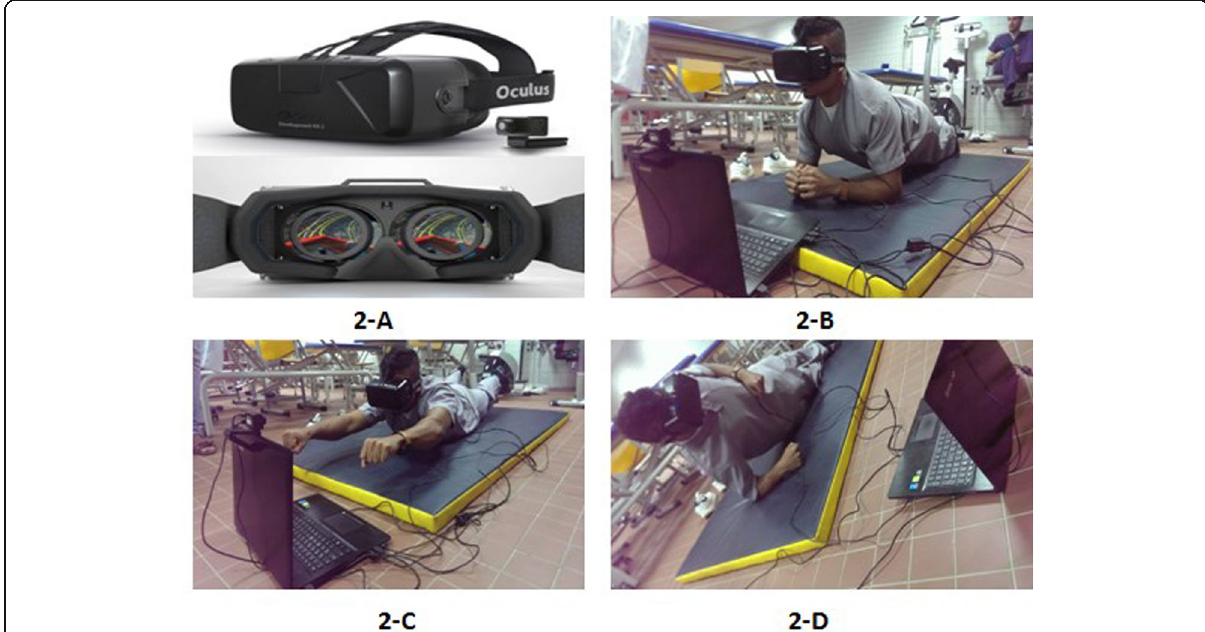
Fig. 2 Core stability exercises. a The Oculus Rift DK2 headset. b The prone plank with Oculus. c Superman plank with Oculus. d The side plank with